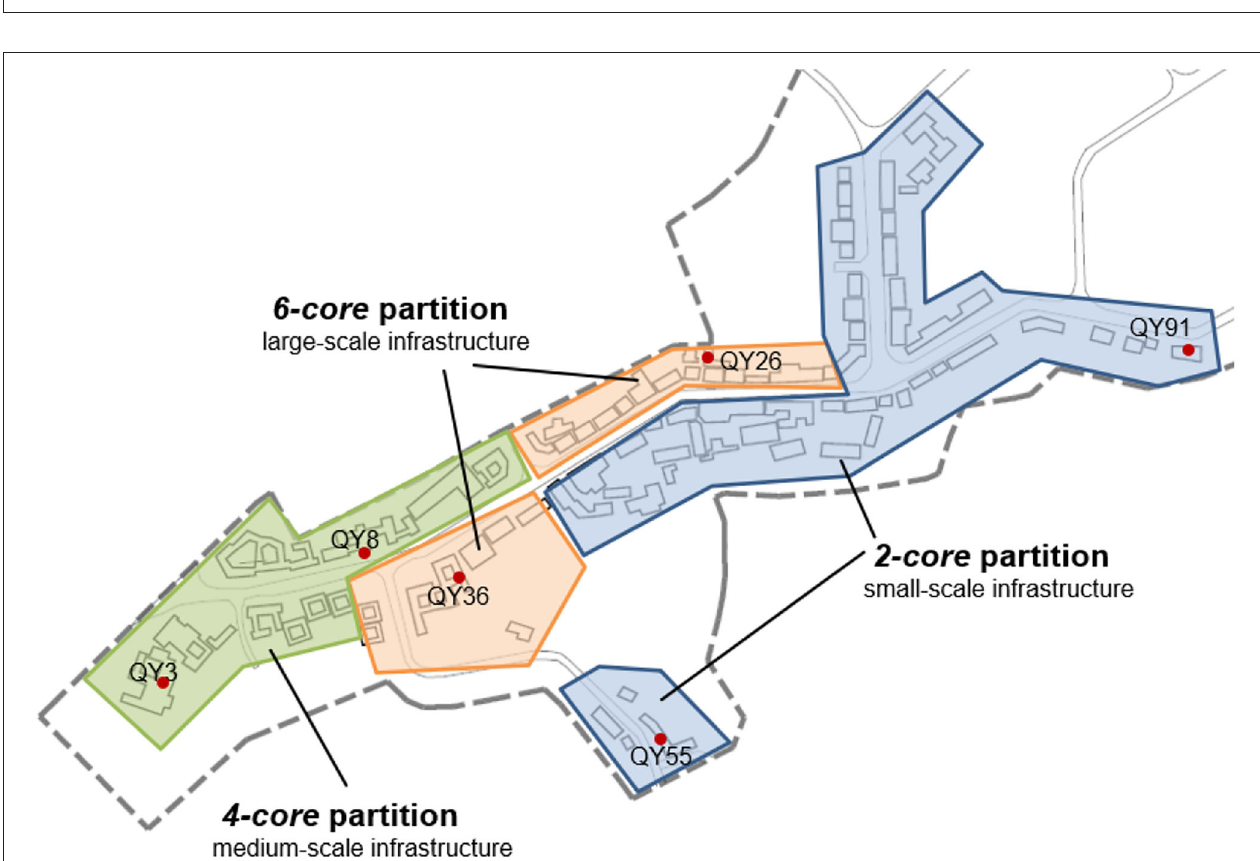
FIGURE 5 | Three-class conservation ranges and corresponding scales of public infrastructure and activity in Qingyang (QY) town based on the analysis of k-core